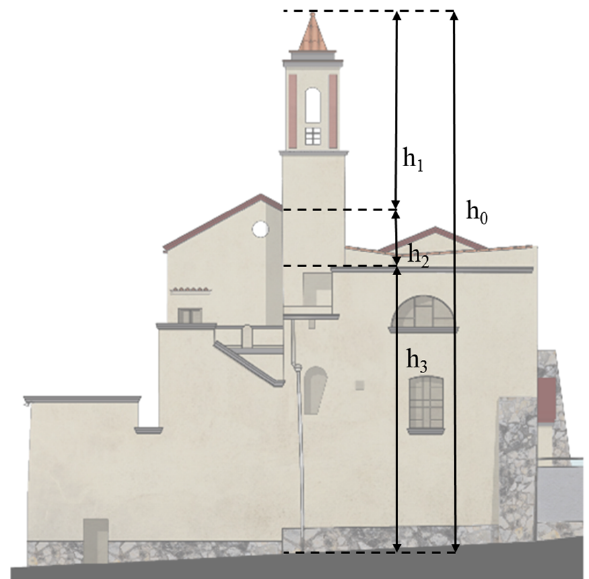
Figure 5. The bell tower of S. Anna in Cervino.